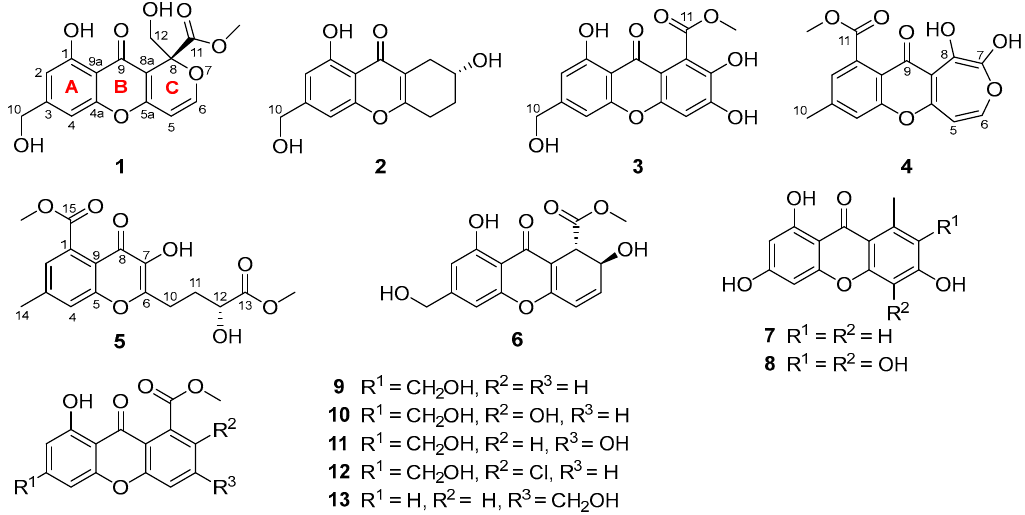
Figure 1. Chemical structures of compounds 1 – 13 .